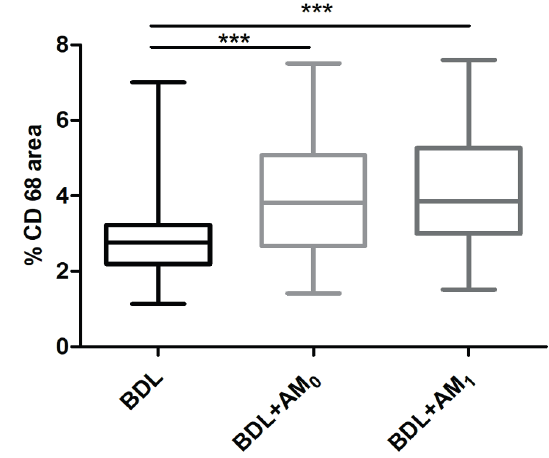
Figure 8 - Quantitative evaluation of Cd68 in the periportal area. median and interquartile range of Cd68 positive macrophages in the experimental groups after 6 weeks of BDL.